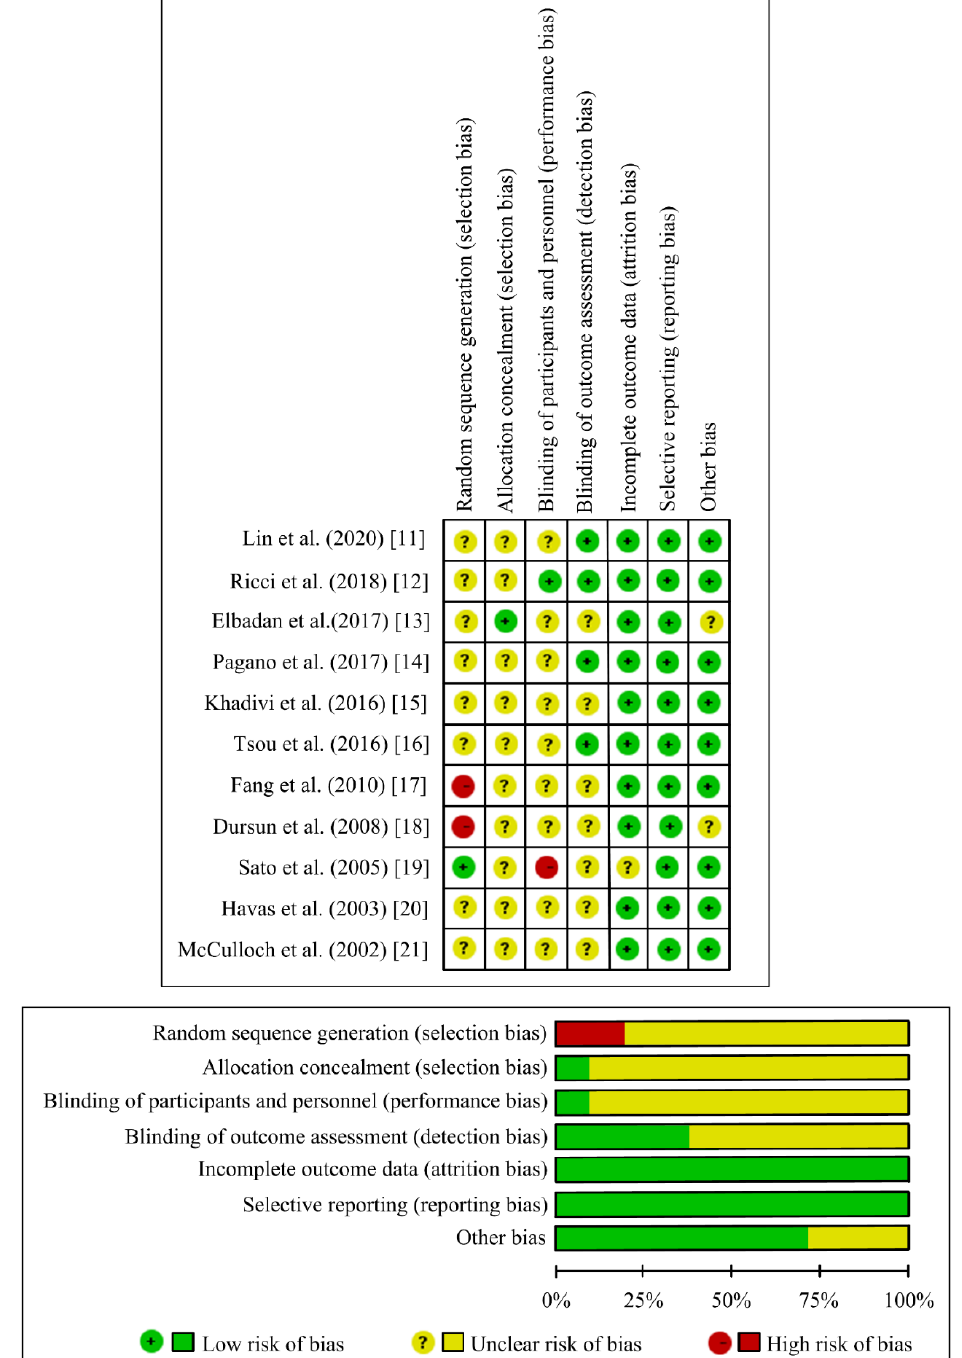
Figure 2. Summary of the risk of bias in 11 included articles.